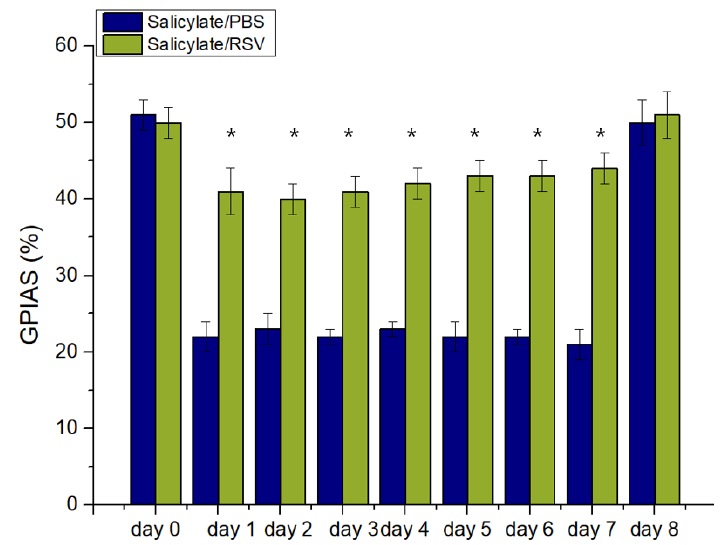
Figure 5. Resveratrol (RSV) attenuated a salicylate-induced decrease in gap-prepulse inhibition of acoustic startle reflex (GPIAS) ratio. From day 1 to 7, RSV treatment protected against a salicylate-induced reduction of the GPIAS ratio in Sprague Dawley rats. * p < 0.05. PBS: phosphate-buffered saline.